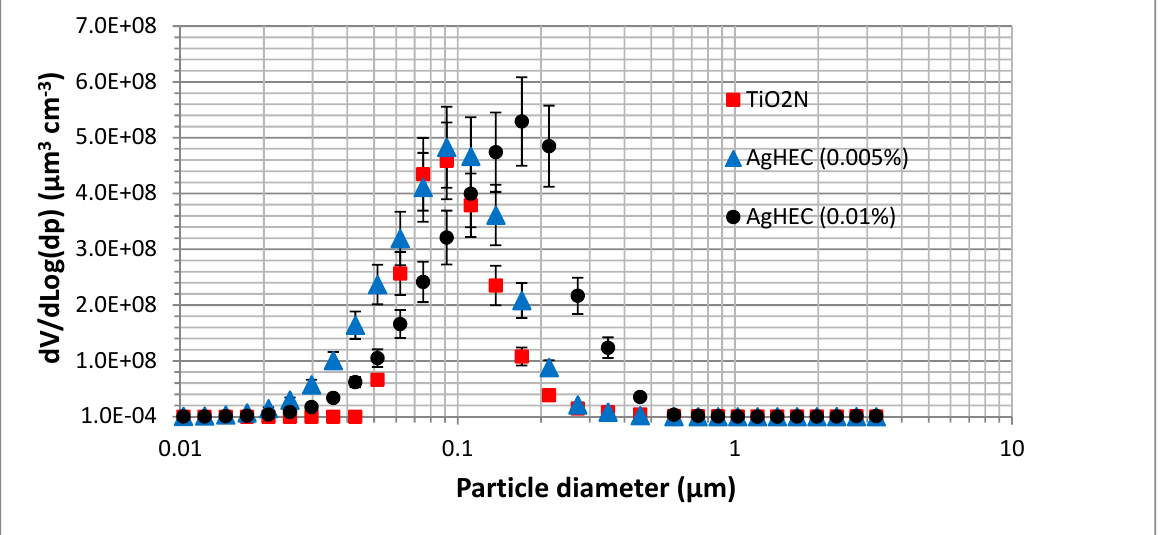
Figure 4. TiO 2 N and AgHEC volume size distributions obtained with laboratory-generated suspensions. Bars show one standard deviation.